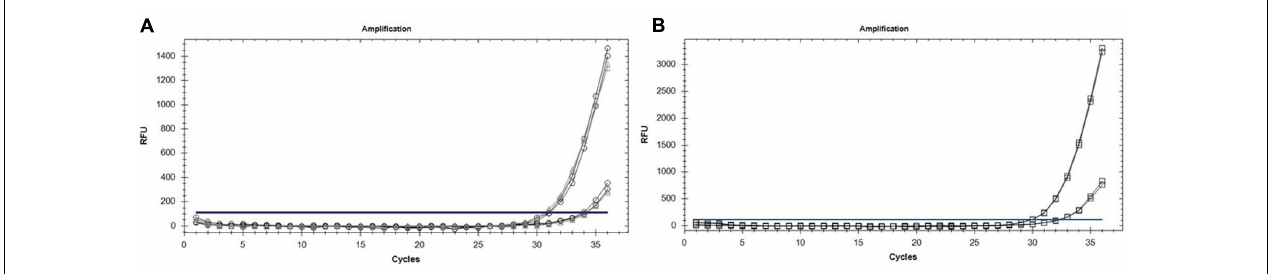
FIGURE 3 | (A) Amplification curves showing the detection efficiency of sensitive ( (cid:13) ) and resistant ( (cid:52) ) alleles using the mixtures of DNA from Qol-resistant and Qol-sensitive isolates as a template. (B) Amplification curves showing the detection efficiency of resistant ( (cid:3) ) alleles in uniplex TaqMan real-time PCR using DNA from Qol-resistant isolates as a template.